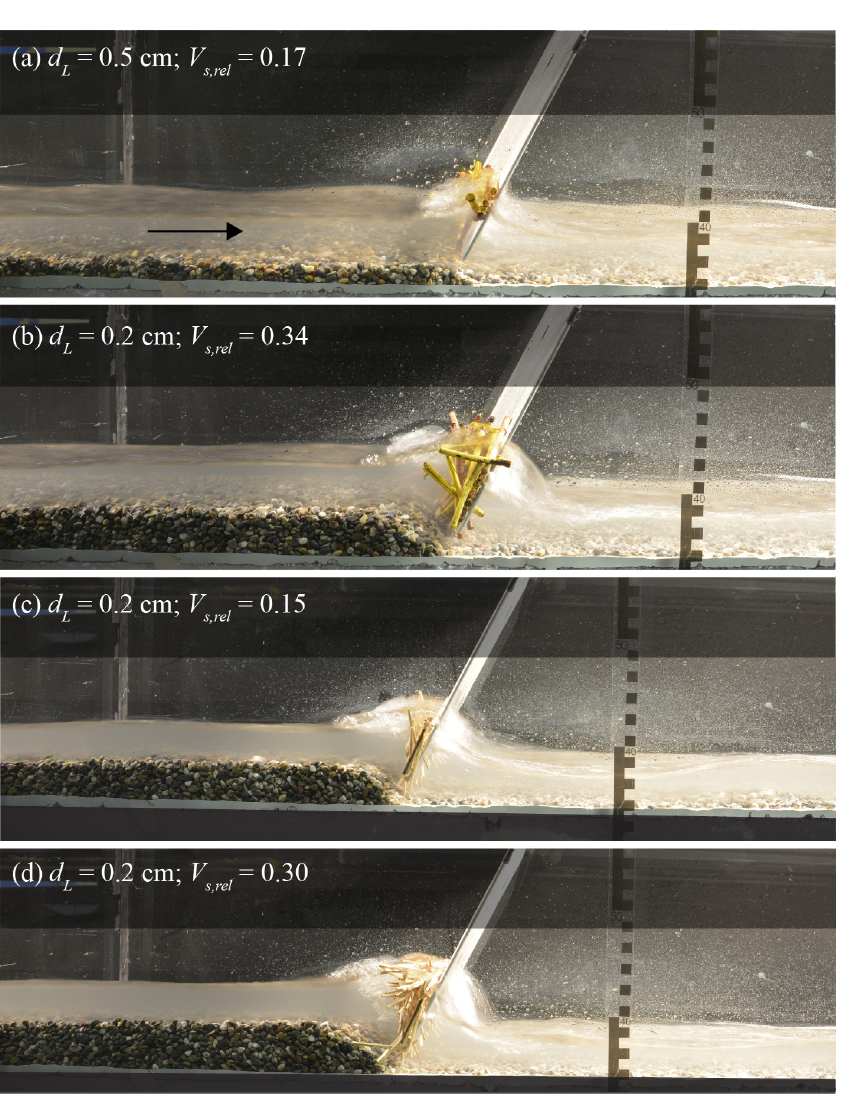
Figure 6. LW accumulation and bedload deposition at the inclined bar screen for ( a ) test V7 ( d L = 0.5 cm and L L = 5–10 cm) with V s , rel = 0.17 and ( b ) V s , rel = 0.34, compared to ( c ) test V8 ( d L = 0.2 cm and L L = 5 cm) with V s , rel = 0.15 and ( d ) V s , rel = 0.30.